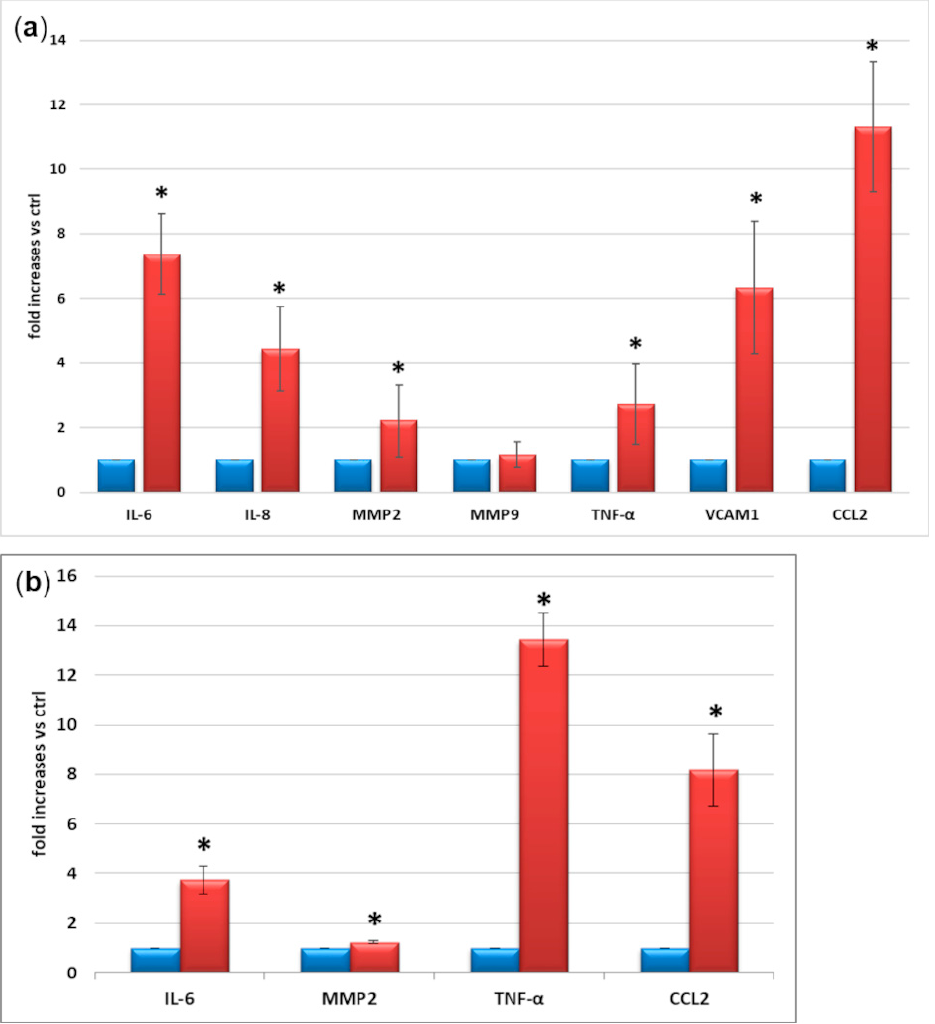
Figure 4. ( a ) mRNA expression and ( b ) secretion in the supernatants of inflammatory markers in control conditions (blue) and after M1 activation (red). M1 activation was achieved by exposing microglial cells for 24 h to TNF α 10 ng/mL + IL1 β 20 ng/mL + IFN γ 50 ng/mL. Mean of five experiments ± SD, * p < 0.05.